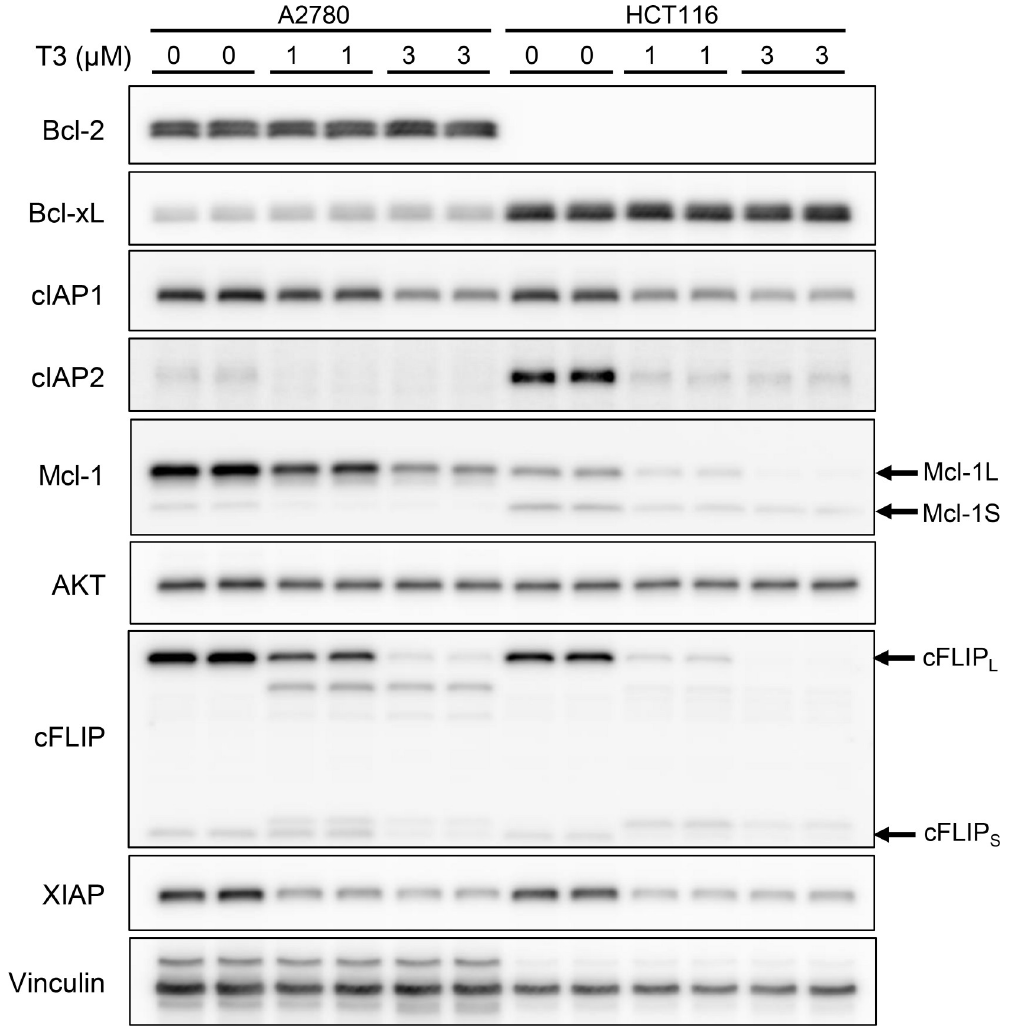
Fig 2. T3-induced reduction of anti-apoptotic proteins expression in A2780 and HCT116 cells. Immunoblot analyses were performed using protein lysates from A2780 and HCT116 cells treated with T3 for 16 h at the indicated concentrations. The positions of Mcl-1L, Mcl-1S, cFLIP L , and cFLIP S are indicated on the right. Uncropped blot images are shown in S2 File.